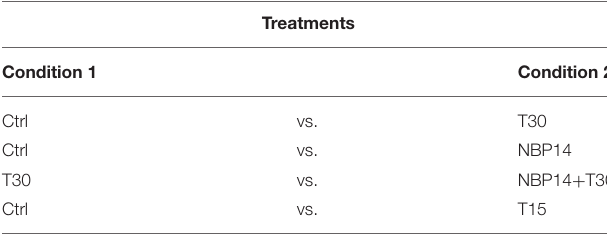
TABLE 2 | Treatments and related conditions used in this study.